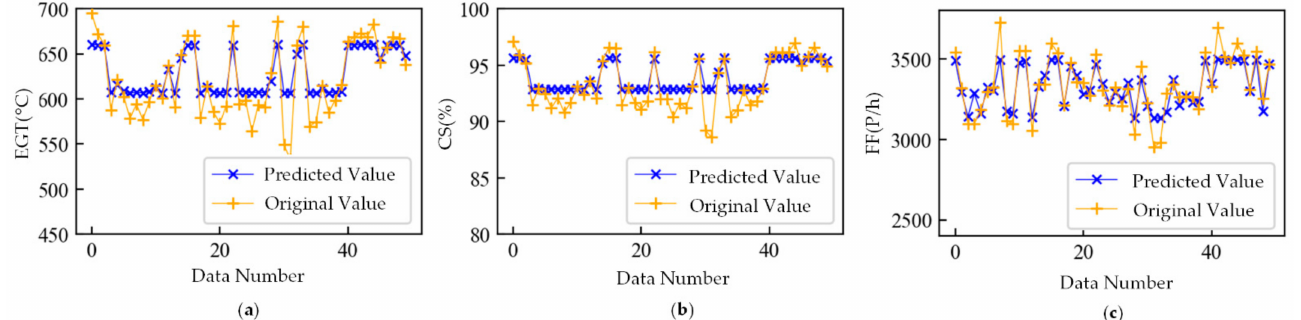
Figure 13. Mining results of the mapping relationship mining model with only the encoder-decoder and LSTM. ( a ) The predicted and original values of exhaust gas temperature; ( b ) the predicted and original values of core speed; ( c ) the predicted and original values of fuel flow.